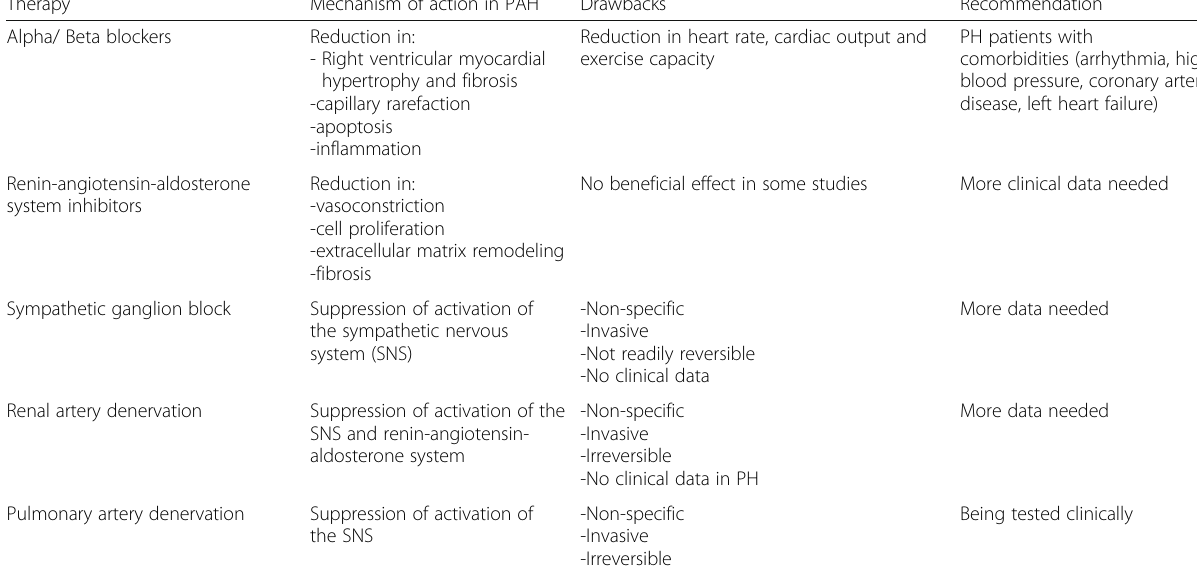
Table 1 Pharmacological and invasive therapies targeting the autonomic nervous system in pulmonary arterial hypertension